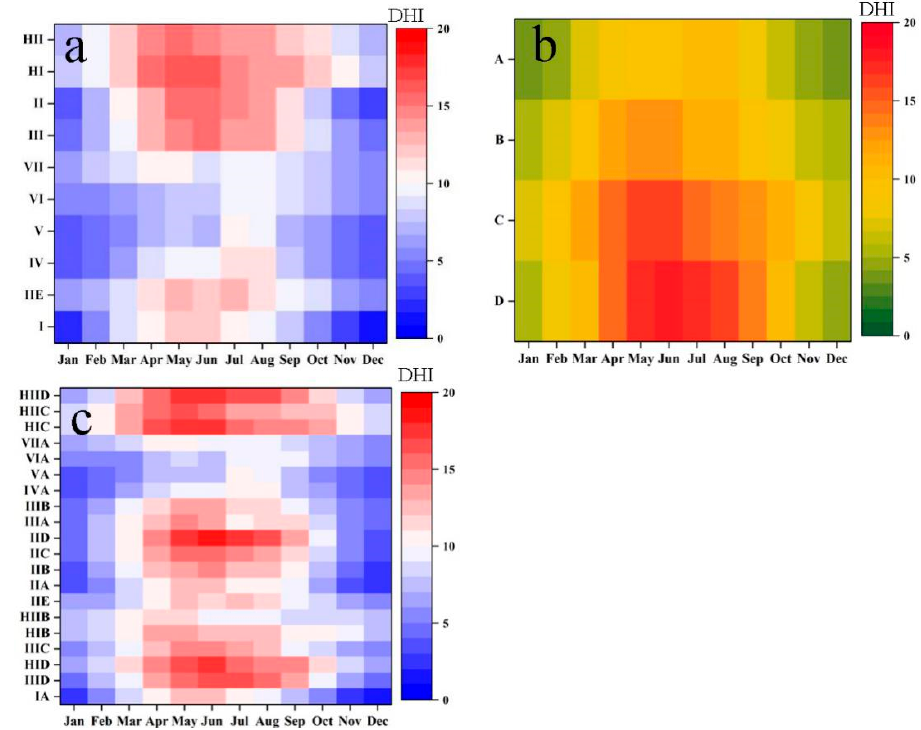
Figure 11. Monthly mean DHI (MJ m − 2 day − 1 ) values in different climatic zones. The zones are defined based on both temperature and humidity ( a ) Temperature zones, ( b ) humidity zones, ( c ) climatic zones.